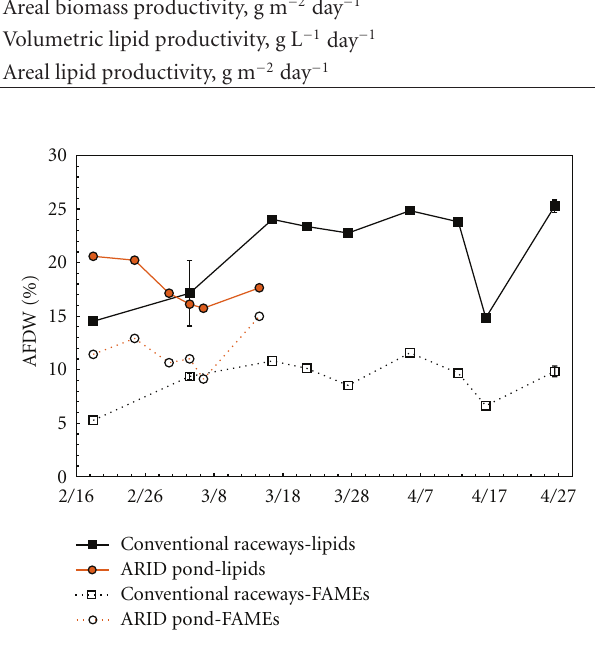
Figure 7: Lipid and FAME content of the ARID pond and conventional raceways, expressed as a percentage of AFDW.